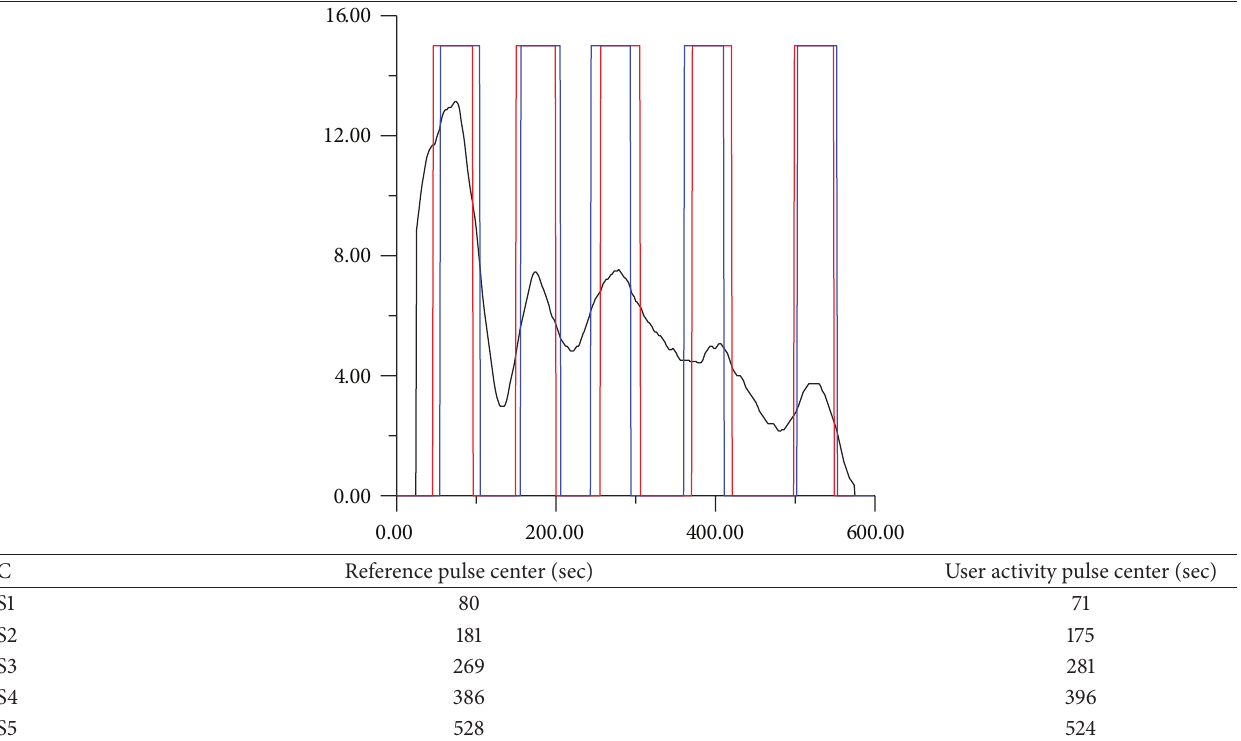
Table 4: Video C is a lecture video (http://www.youtube.com/watch?v=Z09ythJT9Wk). The pulse width 𝐷 is 50 seconds and the smoothing window 𝑇 is 50 seconds. The pulse modeling is reported with respect to the center of each pulse.